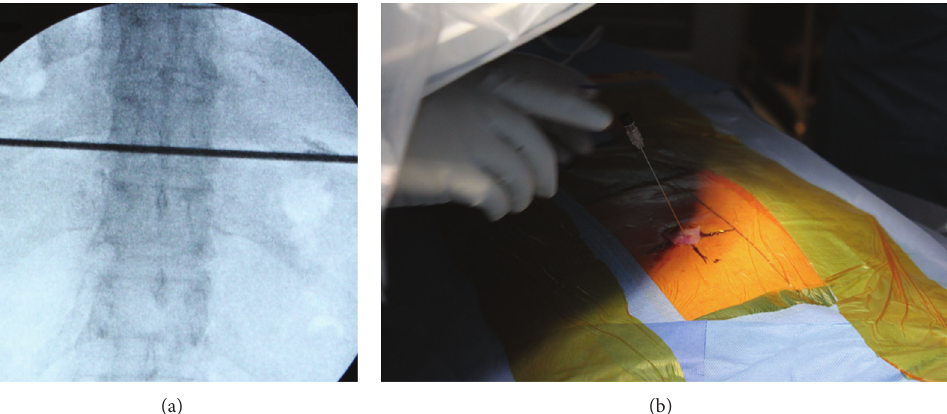
Figure 1: The target disc was identified under fluoroscopic guidance (a), and the entry point between the rib head and the facet was marked on the skin (b).